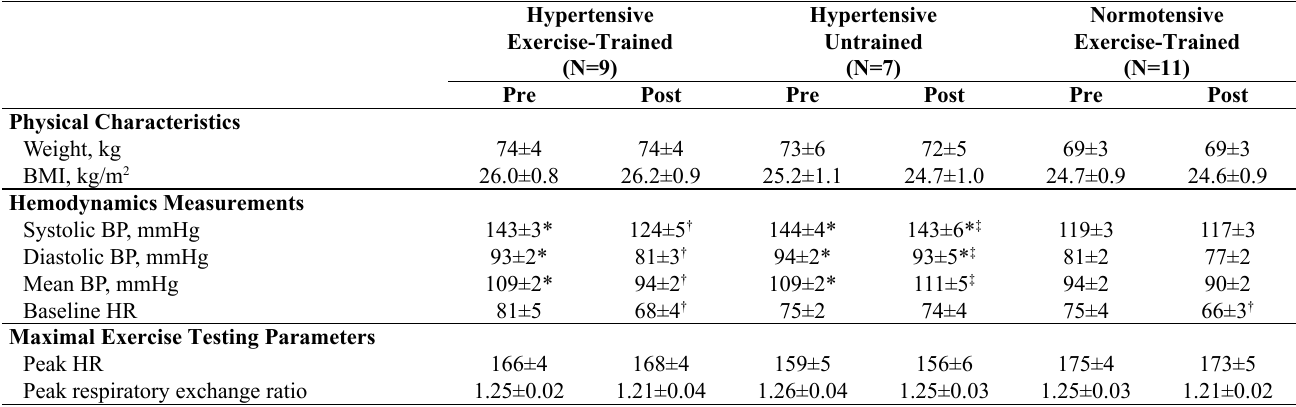
Table 2. Hemodynamic Measurements and Maximal Exercise Testing Parameters Pre and Post intervention in exercise-trained hypertensive, untrained hypertensive and exercise-trained normotensive groups.